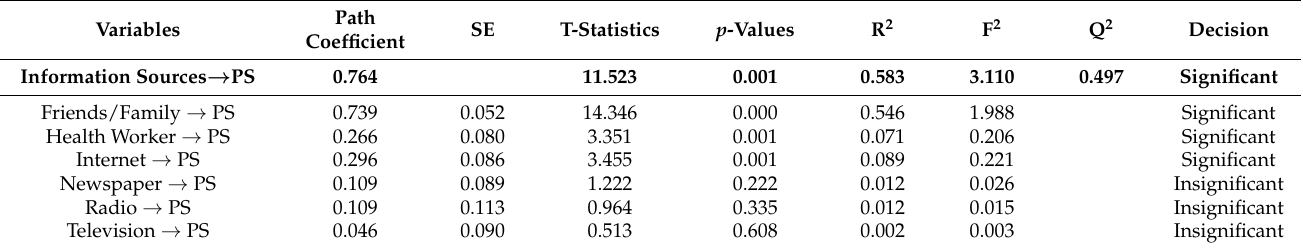
Table 13. Coefficient value of Hypothesis